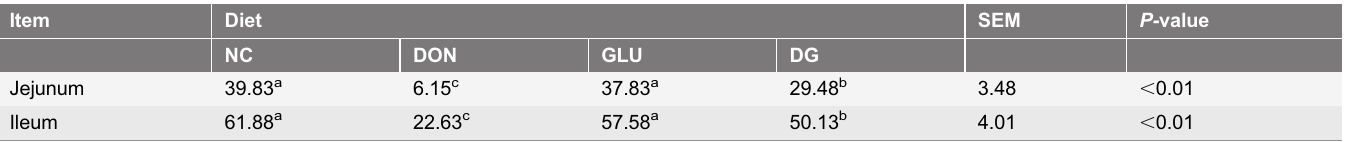
a-c Values with different letters within the same row are different ( P , 0.05, one way ANOVA method). 1 Dietary treatments were NC, an uncontaminated basal diet, DON, the basal contaminated with 4mg/kg deoxynivalenol, GLU, uncontaminated basal diet with 2% glutamic acid supplementation, and DG, deoxynivalenol-contaminated (4 mg/kg) basal diet with 2% glutamic acid supplementation (n 5 5). 2 Proliferating cell nuclear antigen labeling was defined as the ratio of positive cells to total cells in each